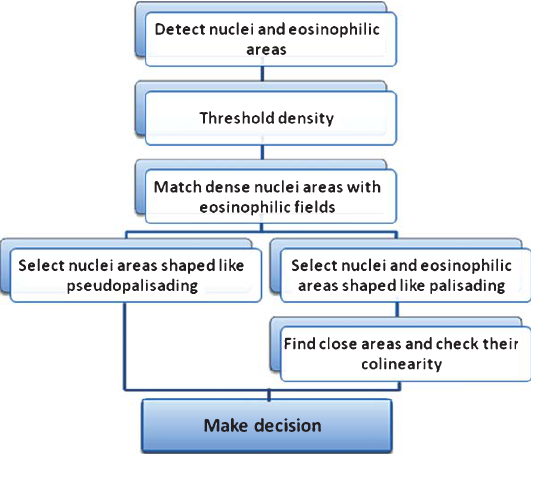
Fig. 1. Fragments of virtual slides belonging to three different classes: ‘Glioblastoma’, ‘Neurinoma’ and